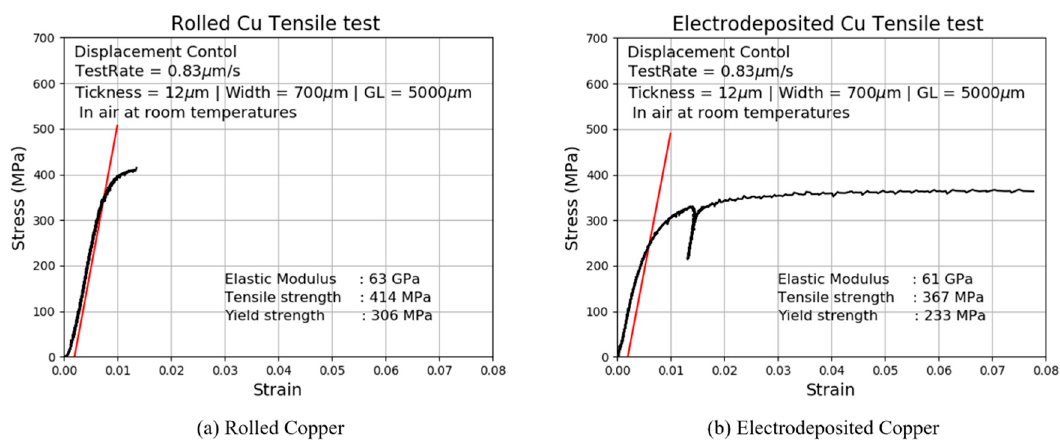
Figure 9. Stress-Strain curves: Mechanical properties for Cu thin films depending on process method.